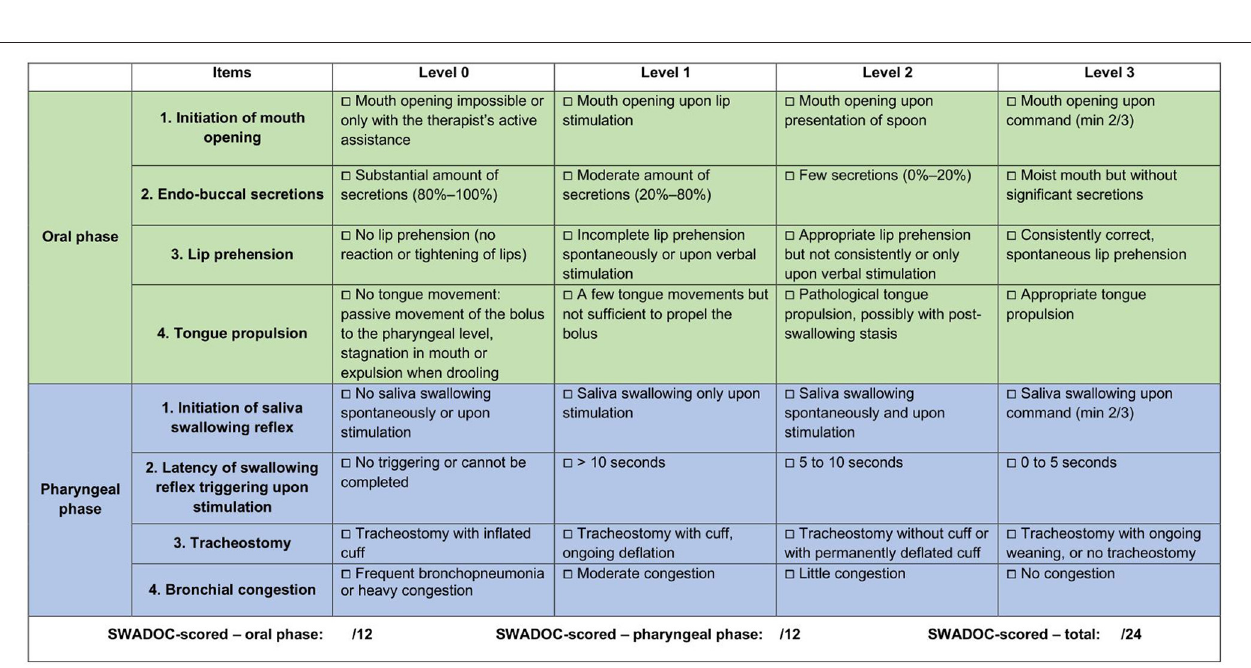
FIGURE 2 | SWADOC-scored (English version). DOC, disorders of consciousness; SWADOC, SWallowing Assessment in Disorders Of Consciousness.